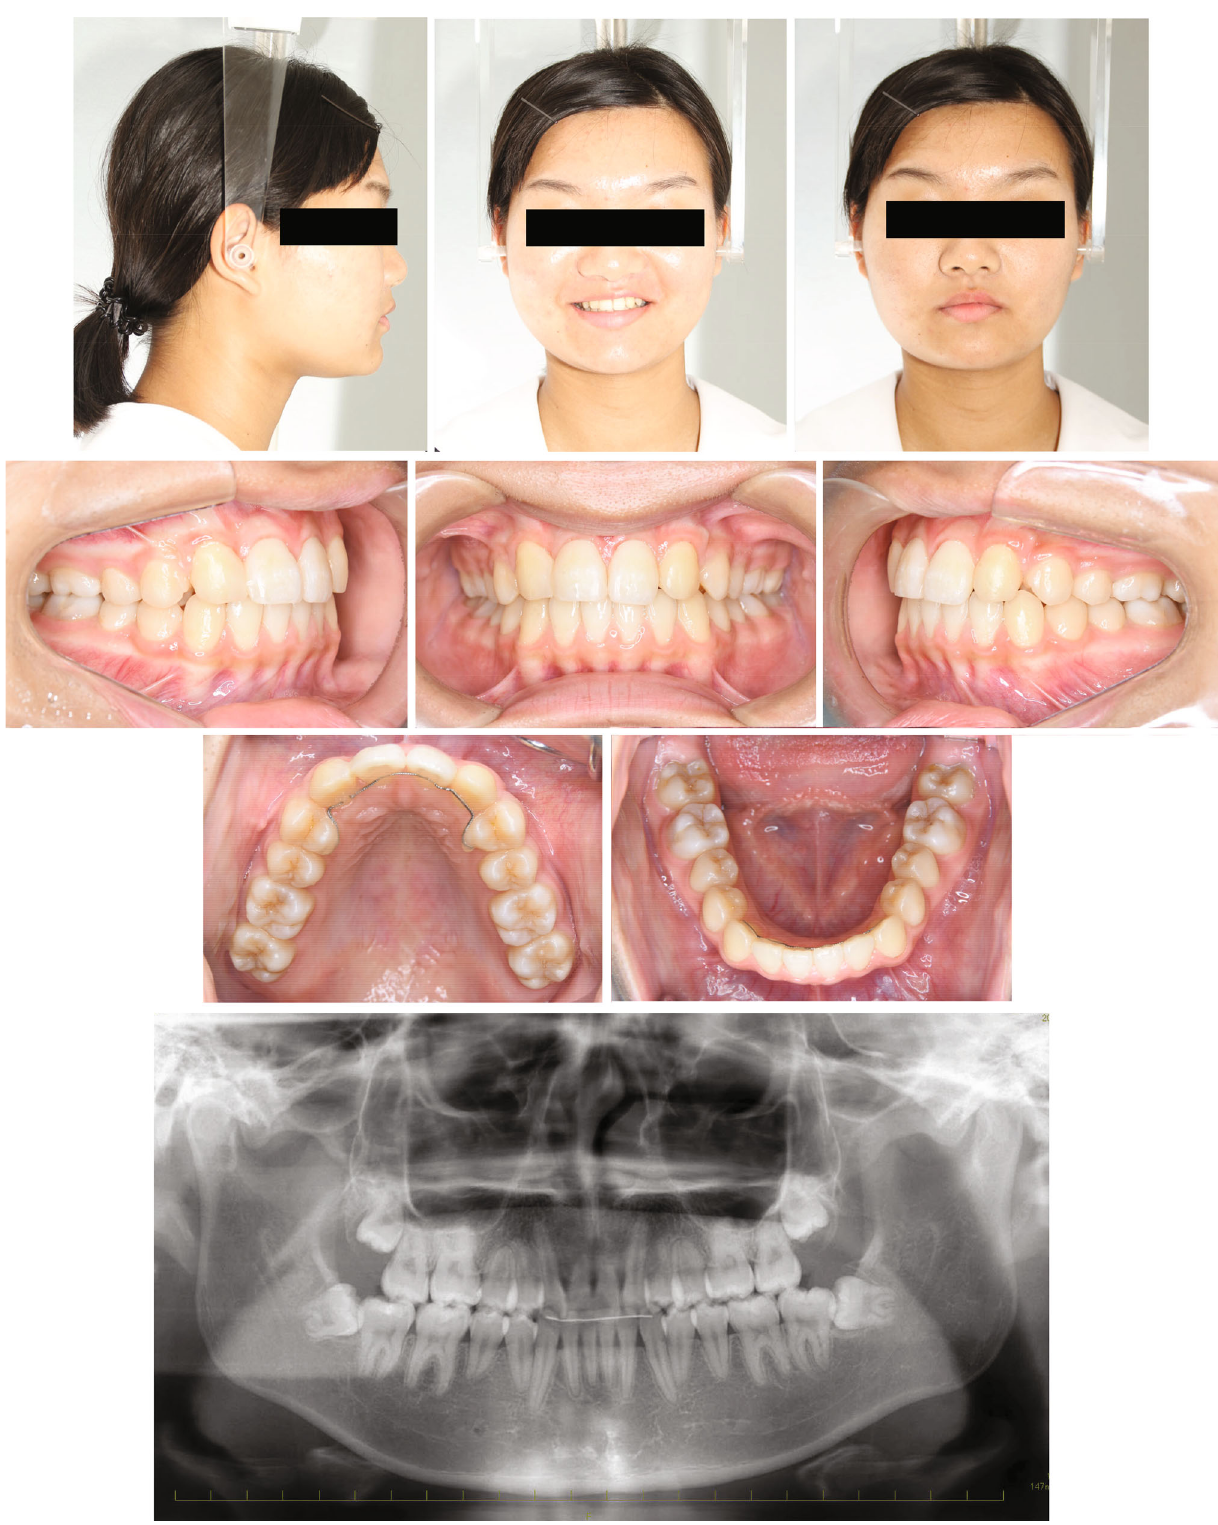
Figure 6: Posttreatment facial and intraoral photographs and panoramic